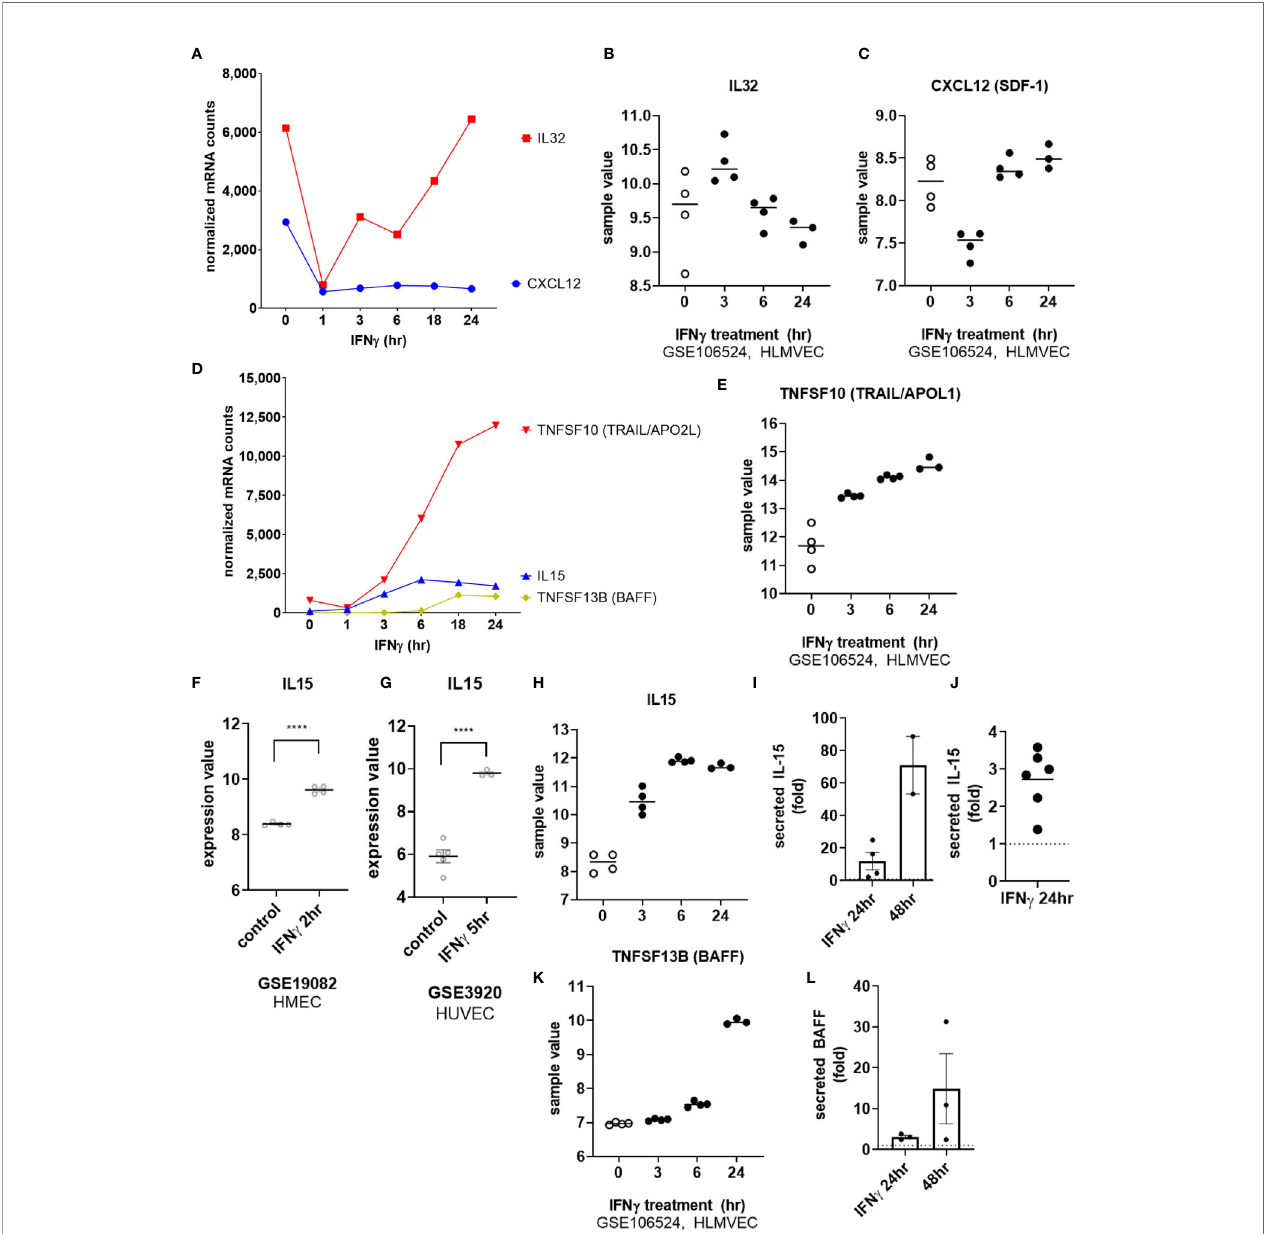
FIGURE 8 | IFN g alters endothelial cytokine expression patterns. (A) HMEC-1 endothelial cells were stimulated with IFN g (200U/mL) for 1hr, 3hr, 6hr, 18hr or 24hr. Time course of IFN g suppressed IL32 and CXCL12 cytokine transcripts in HMEC-1. One representative experiment is shown. Results are presented as absolute number of normalized mRNA counts for each gene, normalized to housekeeping controls. (B, C) Expression values of IL32 and CXCL12 from GSE106524 are plotted. Human lung endothelial cells were stimulated with IFN g for 3hr, 6hr or 24hr (n=3-4). (D) HMEC-1 endothelial cells were stimulated with IFN g (200U/mL) for 1hr, 3hr, 6hr, 18hr or 24hr. Time course of IFN g induced TNFSF10 , IL15 and TNFSF13B cytokine transcripts in HMEC-1. One representative experiment is shown. Results are presented as absolute number of normalized mRNA counts for each gene, normalized to housekeeping controls. (E) Expression values of TNFSF10 from GSE106524 are plotted. Human lung endothelial cells were stimulated with IFN g for 3hr, 6hr or 24hr (n=3-4). (F, G) Expression values of IL15 from GSE3920 are plotted, comparing HMEC (n=3) left untreated or stimulated with IFN g for 2hr (GSE19082, 8f) or HUVEC (n=3) 5hr (GSE3920, 8g). Value distributions were compared by unpaired t test. Results are presented with each measured value, and the line at the median. ****p < 0.0001 compared to control. (H) Expression values of IL15 from GSE106524 are plotted. Human lung endothelial cells were stimulated with IFN g for 3hr, 6hr or 24hr (n=3-4). (I, J) . Primary human aortic endothelial cells (n=2) (I) and HCAEC, HCMVEC, HPAEC, HPMVEC, HLSEC (J) were treated with IFN g for 24hr or 48hr. Conditioned medium was assayed for secreted IL-15 protein by ELISA. Results are presented as fold increase in the concentration of secreted cytokine compared to untreated controls at the same time point. (K) Expression values of TNFSF13B from GSE106524 are plotted. Human lung endothelial cells were stimulated with IFN g for 3hr, 6hr or 24hr (n=3-4). (L) Primary human aortic endothelial cells were treated with IFN g for 24hr or 48hr. Conditioned medium was assayed for secreted BAFF protein by ELISA. Results are presented as fold increase in the concentration of secreted cytokine compared to untreated controls at the same time point